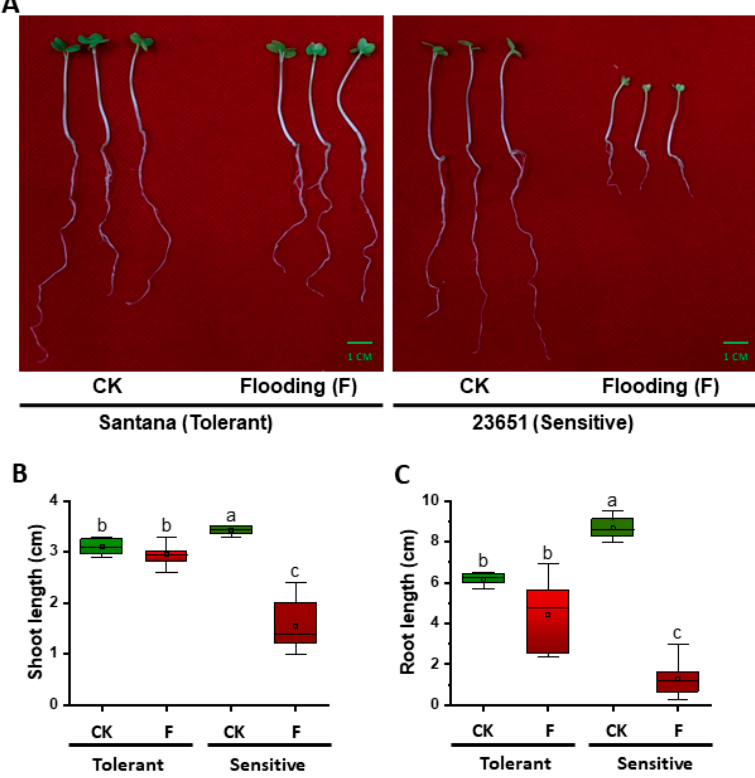
Figure 1. Phenotypic response of tolerant (Santana) and sensitive (23651) rapeseed lines to flooding stress. ( A ) Phenotypes of tolerant and sensitive lines under control treatment and after suffering flooding. Flooding-treated seeds were transplanted into moist vermiculite and cultured for 5 d at 24 ◦ C. Then the growth of seedings was recorded and the pictures were taken. Shoot ( B ) and root length ( C ) of tolerant and sensitive lines under control treatment (CK) and after suffering flooding (F) ( n = 4 for CK, n = 10 for F; medians: 3.10, 2.95, 3.45, and 1.40 for shoot length and 6.25, 84.75, 8.60, and 1.20 for root length). Flooding treatment was repeated three times with consistent results. Letters show significant differences checked by two-way ANOVA